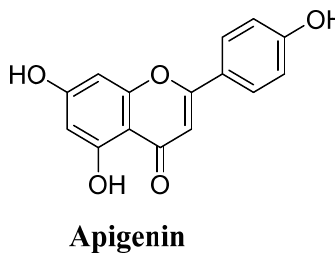
Figure 5. Figure 5. Apigenin.